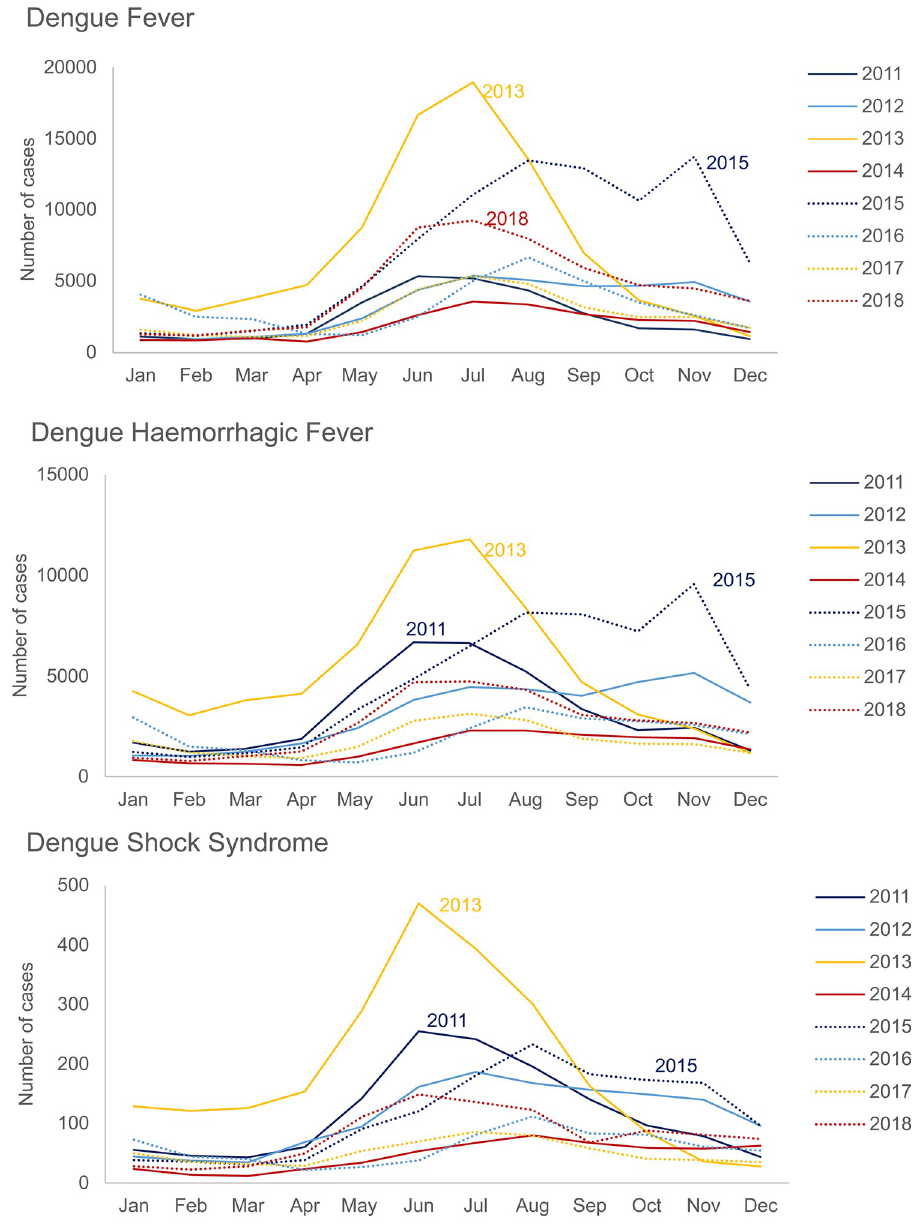
Fig 6. Number of dengue cases by 1997 WHO case definition per month between 2011–2018; Source MoPH [12]. and period (2011–2013) during the CYD14 trial, Coudeville et al. used an EF of 6.2 to account for dengue cases in all age groups [53]. Using a similar method, Nealon et al., reported the highest EFs: 12 for VCD cases, 8.8 for clinically diagnosed dengue, and 8.6 for clinically diag- nosed and VCD cases [14]. Both studies were based on the same trial and were more robust methodologically, since the EFs were obtained by comparing the incidences from the active surveillance of the control arm of the CYD14 trial with the incidence rates obtained from the national passive surveillance systems.